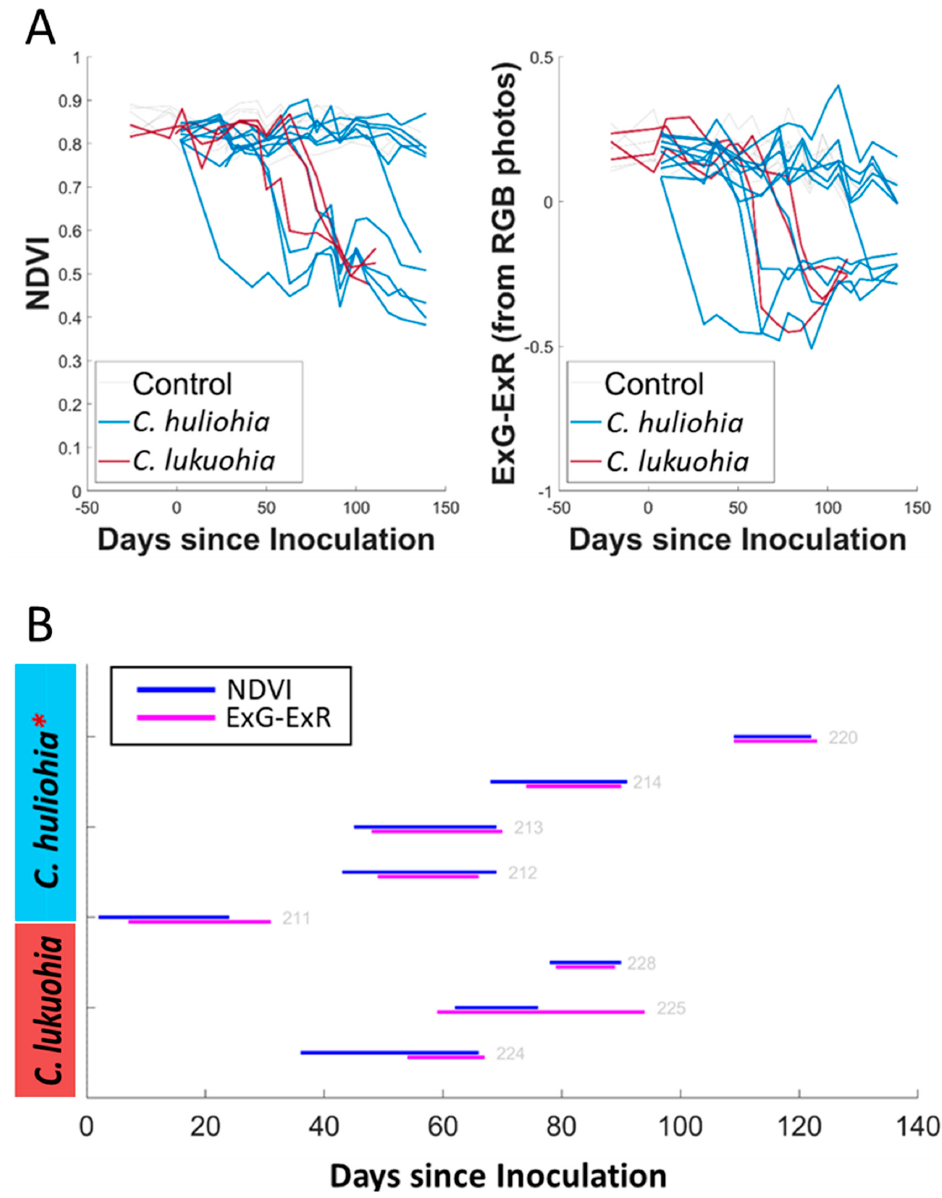
Figure 12. ( A ) Time series VI curves for NDVI (top left) and (top right) ExG-ExR from sUAS imagery of all trees monitored in the Waiakea Forest Reserve inoculation field trial. ( B ) Horizontal bars representing onset and duration of active wilting phase from NDVI (blue) and ExG-ExR (magenta) VIs for affected trees. *Symptomatic trees originally inoculated with C. huliohia were determined to be co-infected with C. lukuohia upon laboratory